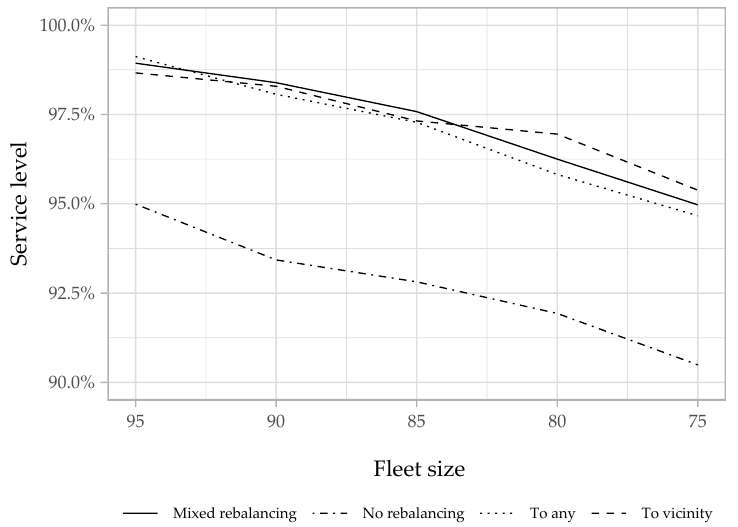
Figure 15. Variation of the service level for different fleet sizes for